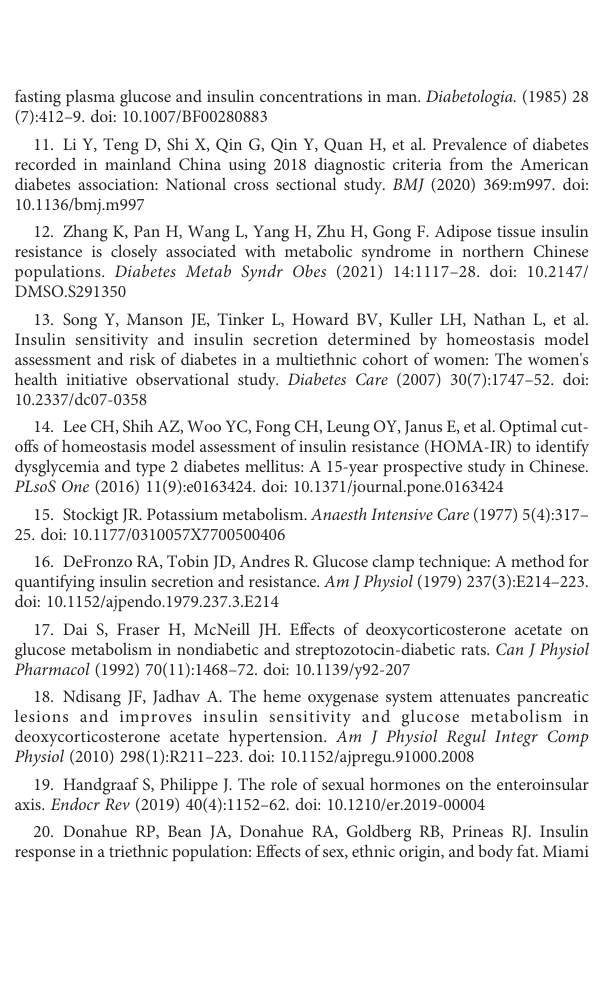
SUPPLEMENTARY TABLE 1 Baseline clinical data of 23 patients categorized by glycaemia situation. Data was presented as mean(SD) or median(range) SD: standard deviation; BMI: body mass index; SBP: systolic blood pressure; DBP: